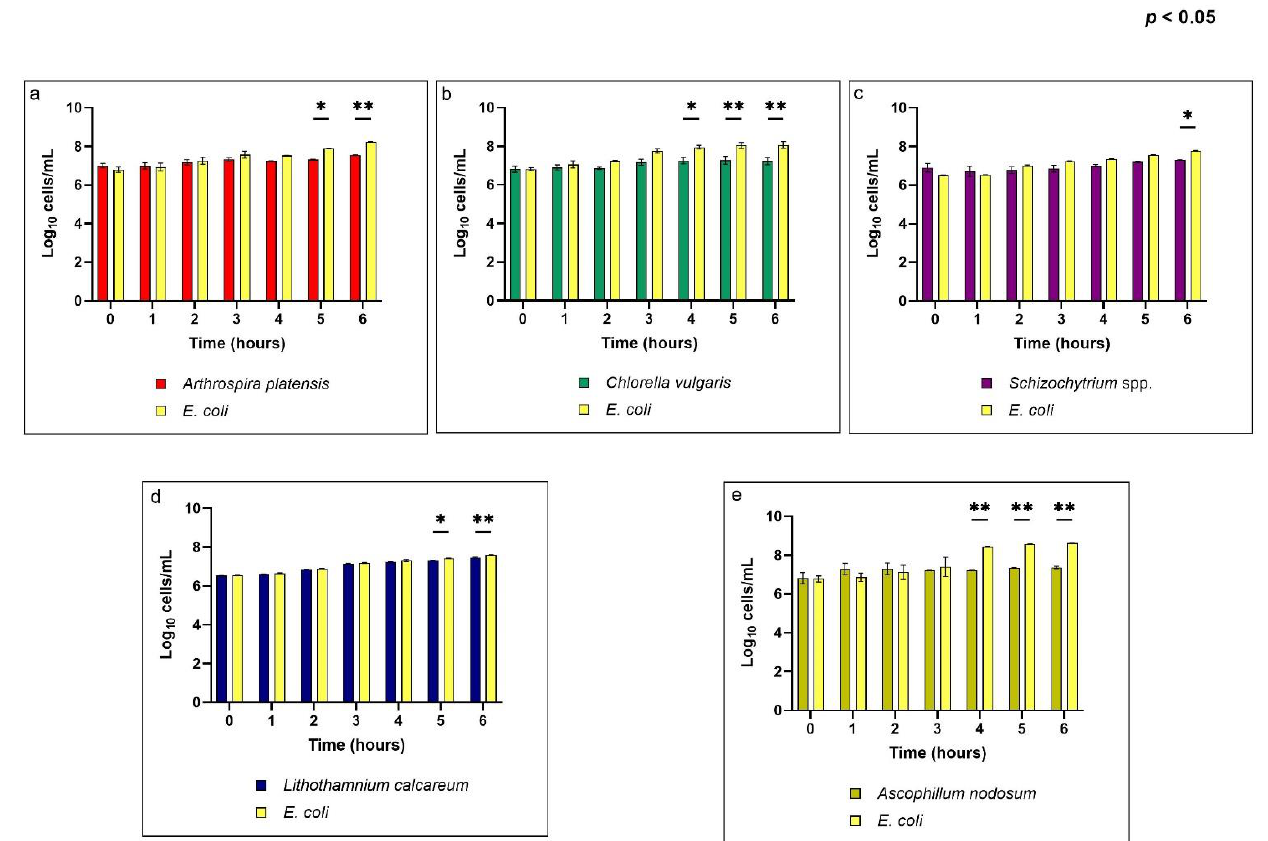
Figure 3. Evaluation of growth inhibition of Arthrospira platensis , Chlorella vulgaris , Schizochytrium spp., Lithothamnium calcareum and Ascophyllum nodosum extracts at a dilution of 1:4 against E. coli . ( a ) Growth inhibition of Arthrospira platensis . ( b ) Growth inhibition of Chlorella vulgaris . ( c ) Growth inhibition of Schizochytrium spp. ( d ) Growth inhibition of Lithothamnium calcareum . ( e ) Growth inhi- bition of Ascophyllum nodosum . Data are shown as means and standard deviations. * Asterisk means (n = 3) with different superscripts are significantly different (Treatment p < 0.05).